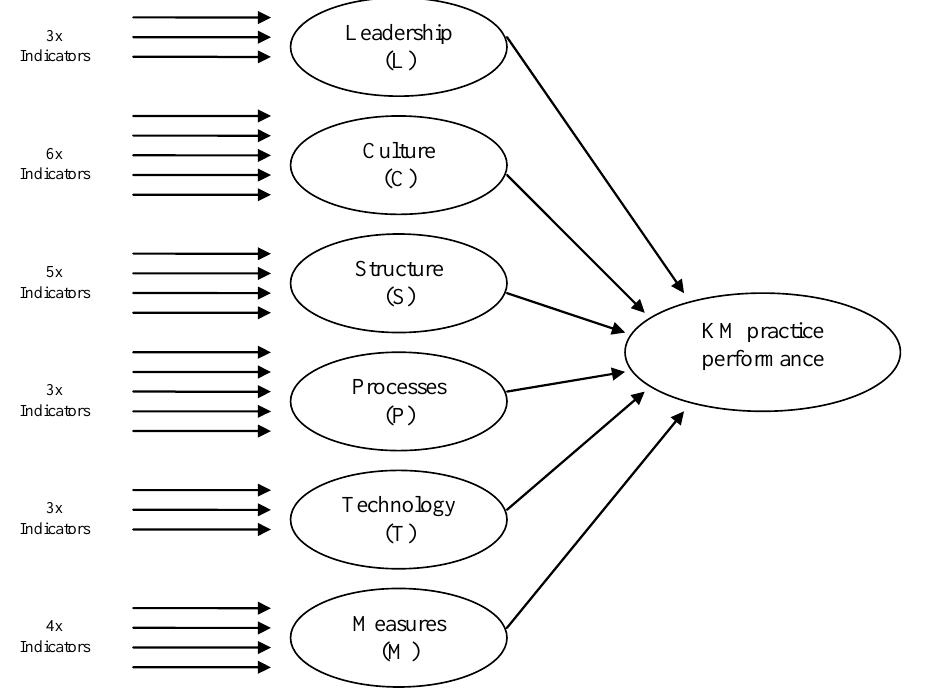
Figure 1: Knowledge Management Reference Model